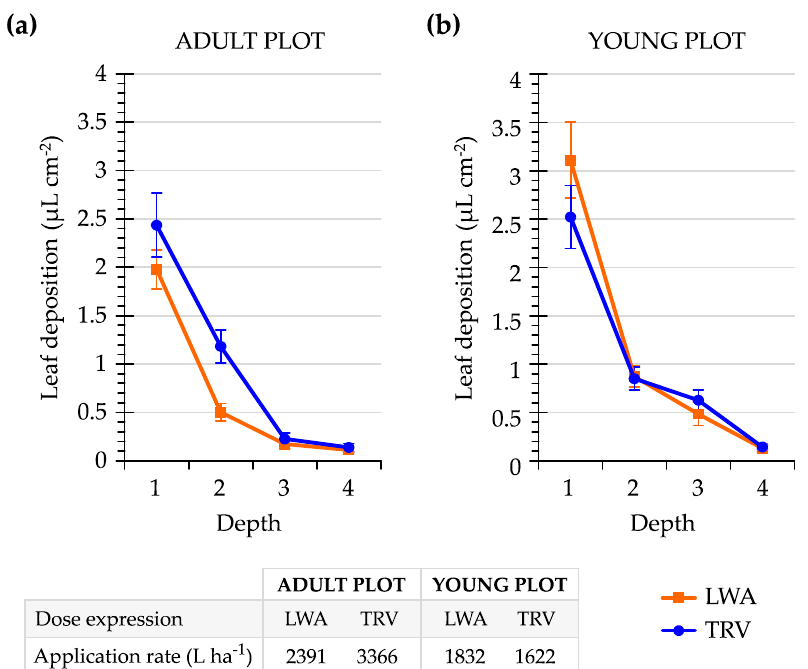
Figure 8. “Dose Expression × Depth” interaction for leaf deposition ( μ L cm − 2 ) (mean (s.e.)) for the ( a ) adult and ( b ) young plots.